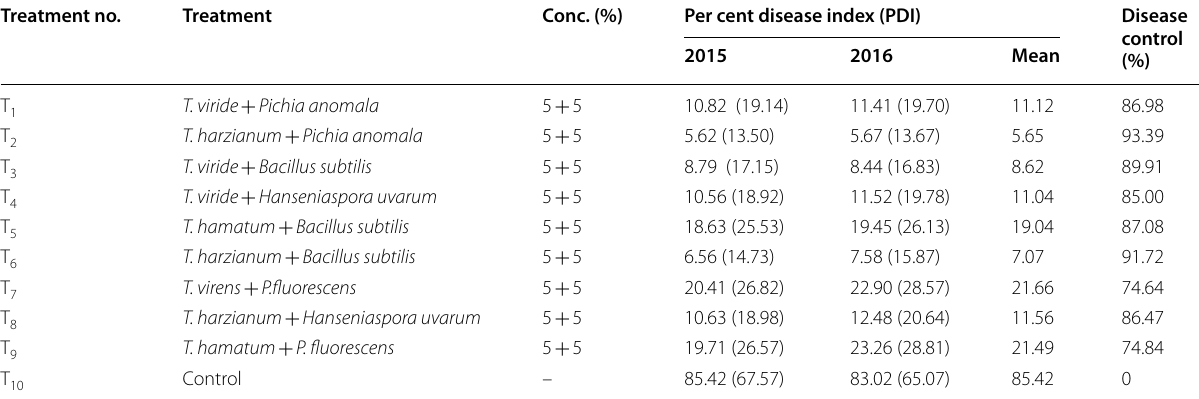
Figures in parentheses are angular transformed values